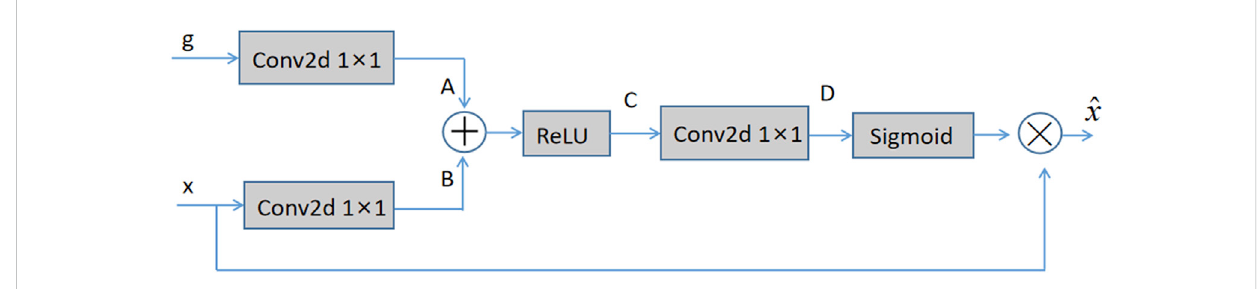
FIGURE 2 Attention gating model.